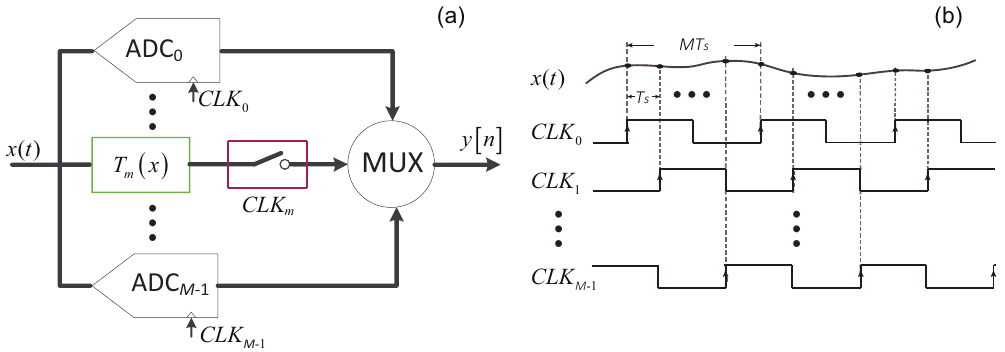
Figure 1. ( a ) A time-interleaved analog-to-digital converter (ADC) consists of M sub-ADCs; ( b ) timing diagram of the sampling clocks. MUX, Multiplexer; CLK,